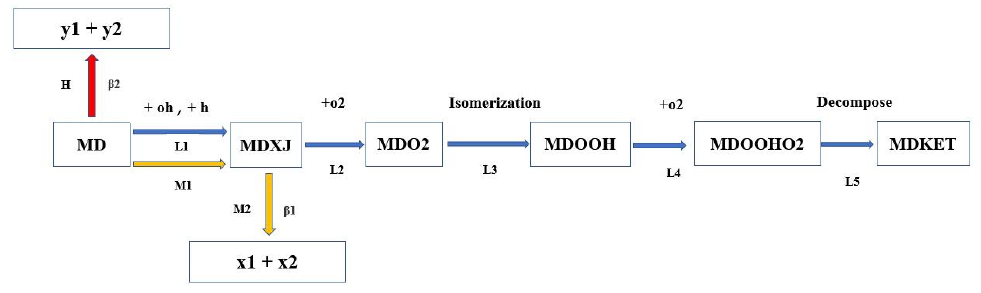
Figure 3. Reaction paths of MD at different temperatures.